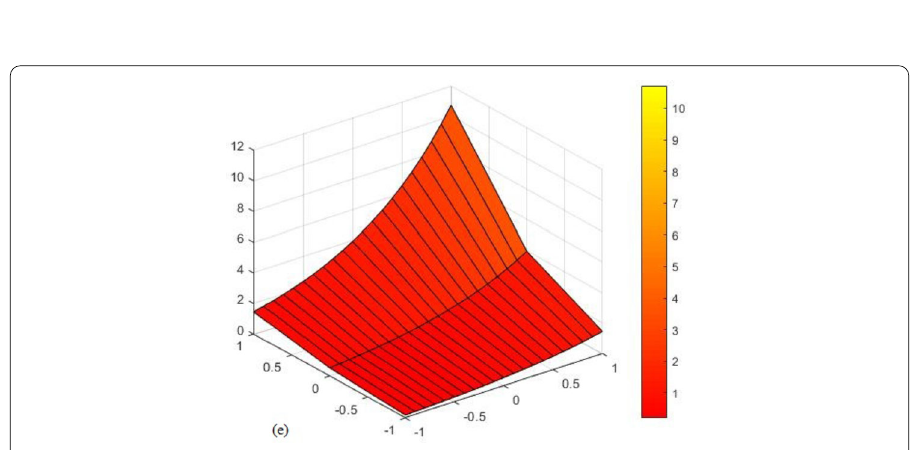
Figure 12 The graph of approximate ( e ) solution of (cid:13) ( χ , ϕ , η ) at ϒ = 0.4 of Example